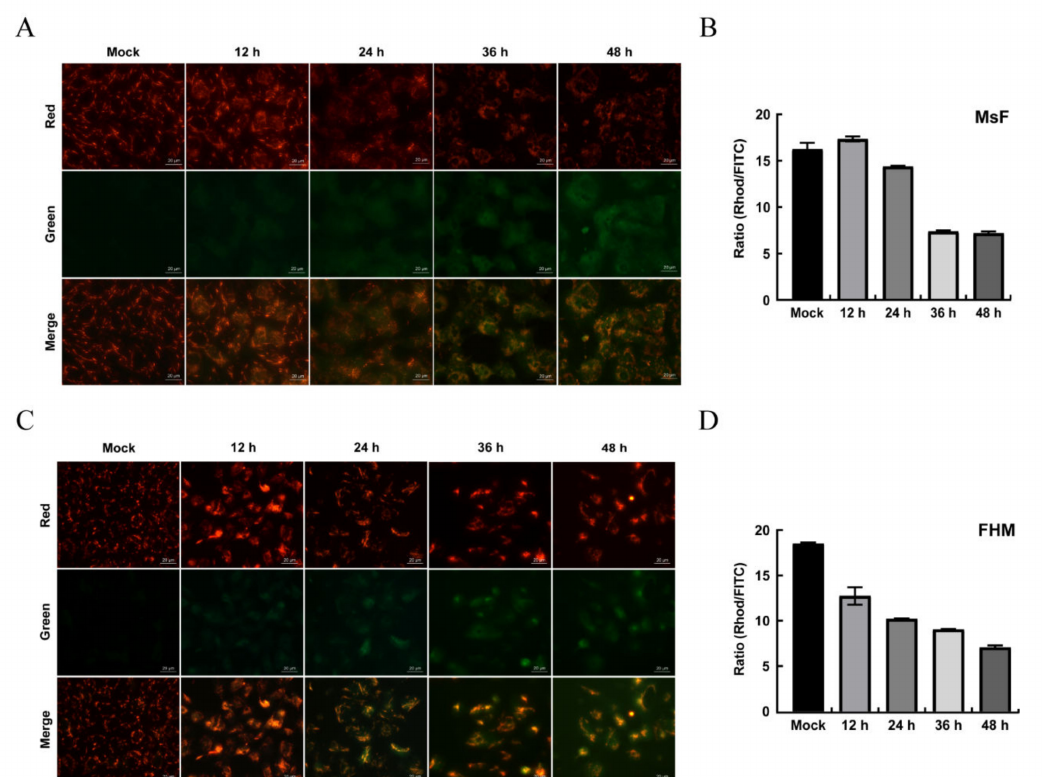
Figure 7. The changes in ∆Ψ m in LMBV-infected MsF and FHM cells. ( A , C ) Fluorescent microscopy observation of the changes in ∆Ψ m in LMBV-infected cells. ( B , D ) Quantitative analysis of the changes in ∆Ψ m in LMBV-infected cells by a microplate reader. After staining with JC-1, mock- or LMBV-infected cells were analyzed by fluorescence microscopy and a microplate